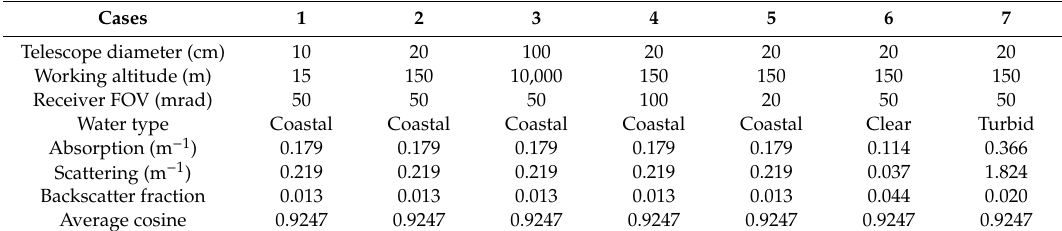
Table 1. Simulation parameters in homogeneous water. FOV: field of view.